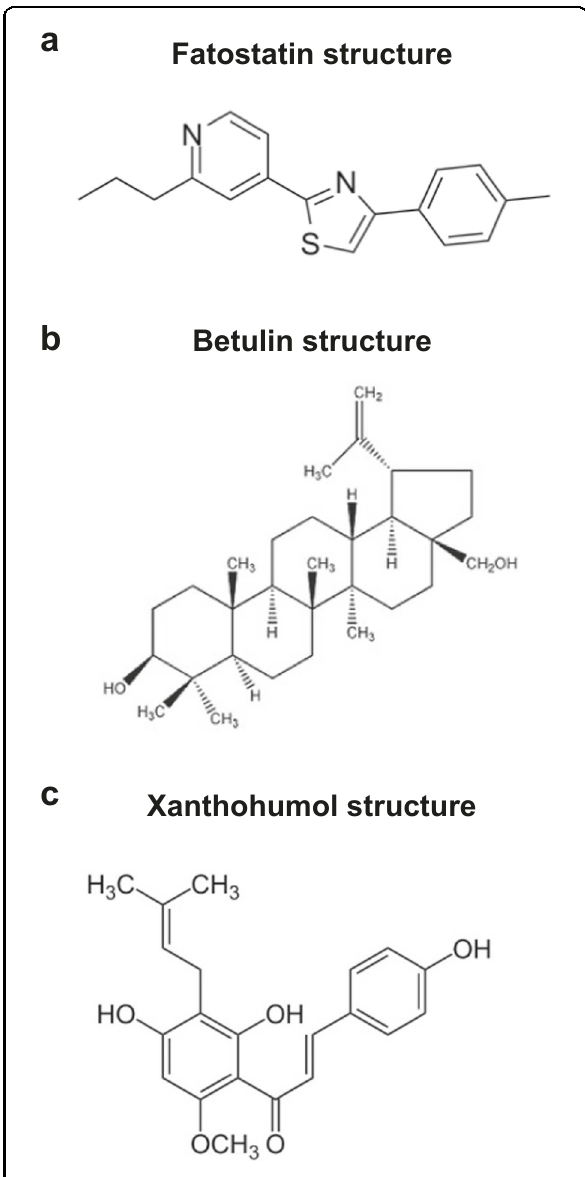
Fig. 3 Small-molecule inhibitors of the SCAP-SREBP complex. a Fatostatin is a chemical inhibitor of the SREBP pathway that directly binds SCAP and blocks its ER-to-Golgi transport. b Betulin enhances the binding of SCAP with INSIGs, thereby promoting the retention of SREBPs in the ER. c Xanthohumol, a prenylated fl avonoid in hops, is an antagonist of